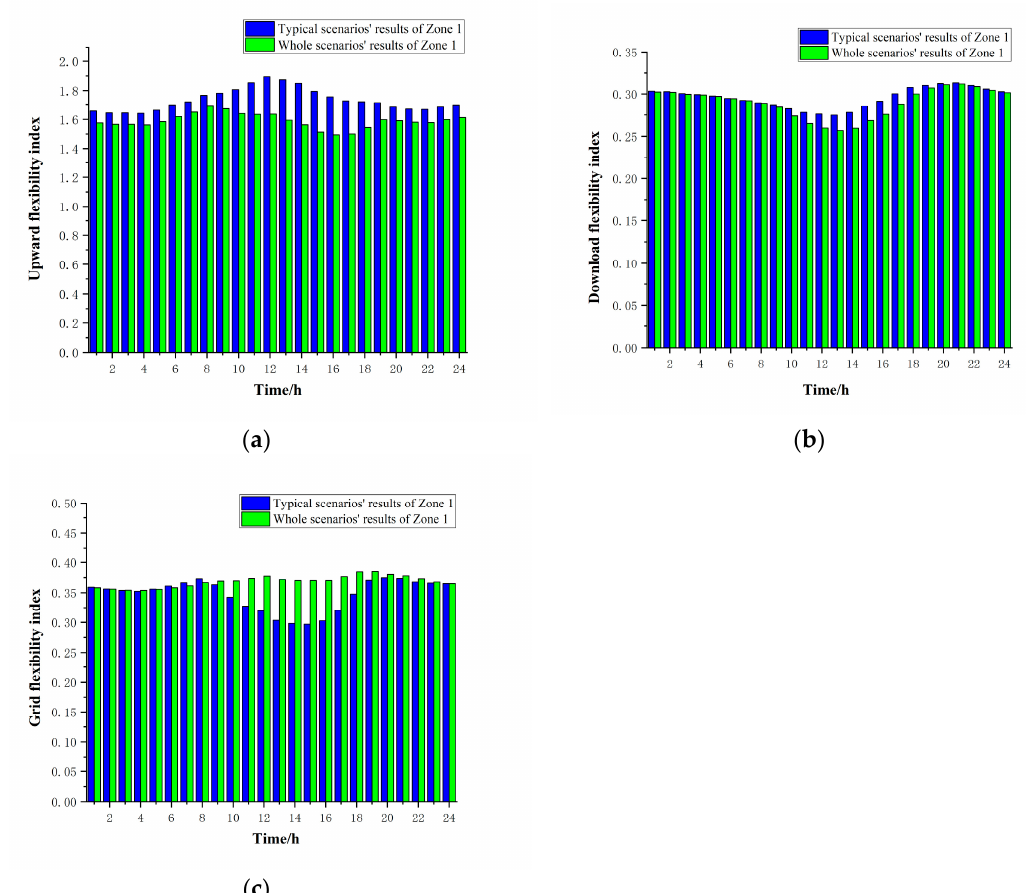
Figure 14 Figure 14. Comparison of flexibility index of Zone 1. ( a ) upward supply and demand flexibility index. ( b ) downward supply and demand flexibility index. ( c ) grid flexibility